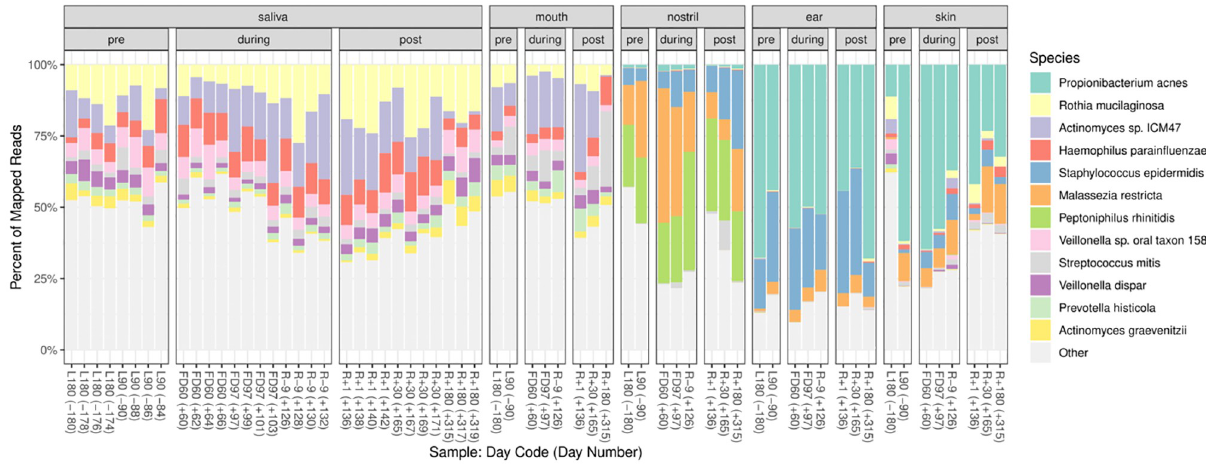
Fig 1. Top 12 most abundant species from crewmember samples pre-, during- and post-flight. The percent of mapped reads from saliva, mouth, nostril, ear and skin samples for each species in each sample (ranked by the average abundance in each panel summed across locations). Each sample’s time point label (day code) and day number are